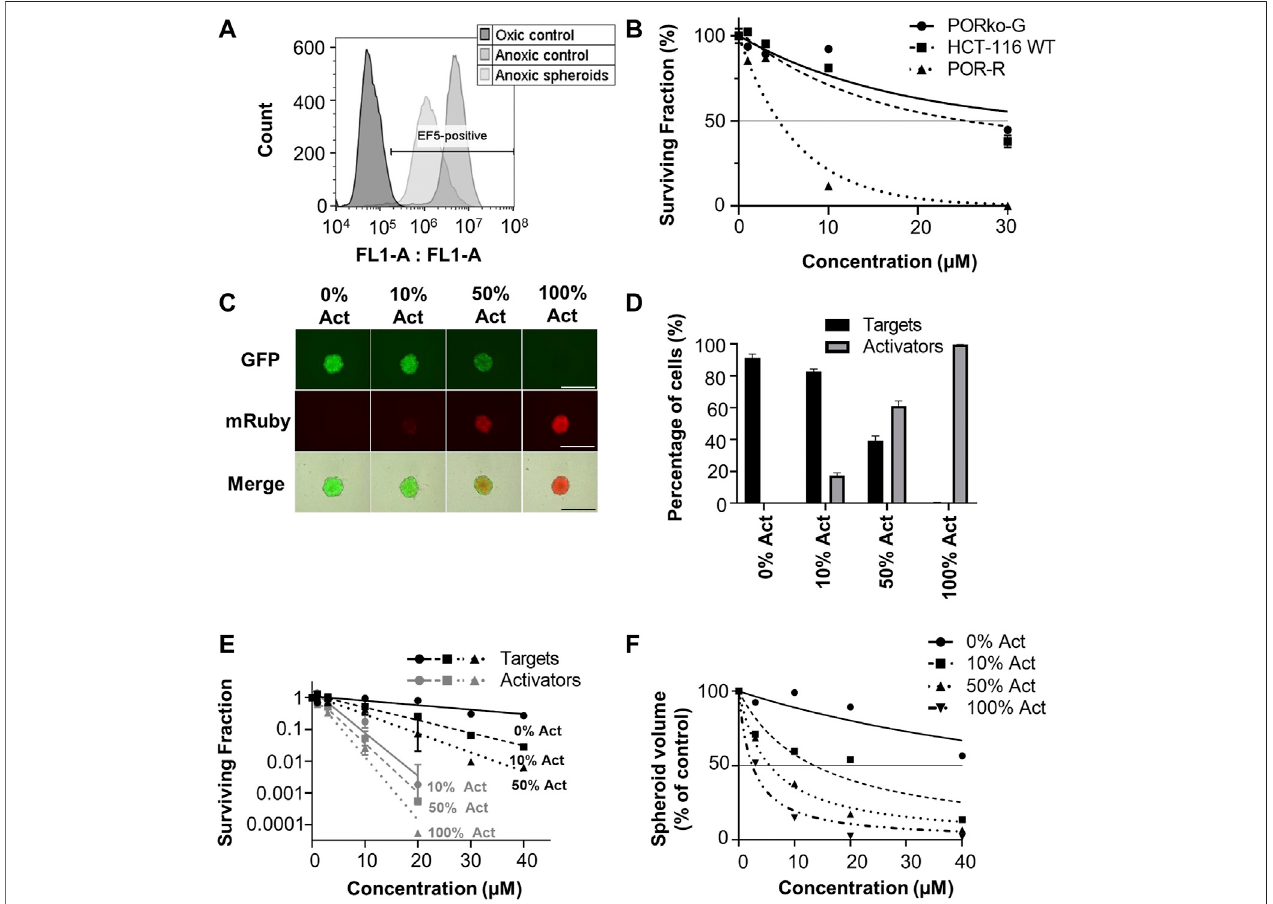
FIGURE 6 | Bystander ef fi ciency of CP-506 in spheroid co-cultures. Multicellular spheroids were established by seeding differing proportions of target (PORko-G) andactivatorcells(POR-R)andgrowingfor4 daysinultra-lowattachment,roundbottom96-wellplates. (A) FlowcytometricanalysisofEF5bindingupontheenzymatic dissociation of anoxia pre-equilibrated POR-R spheroids. The hypoxic population was de fi ned by the hypoxia-selective metabolism and binding of EF5 in monolayer controls. (B) ClonogenicsurvivalafterexposureofspheroidculturestoCP-506for4 hunderanoxicconditions( < 1 ppmO 2 ).IC 50 valueswereinterpolatedfromthe fi tted dose response curve as the concentration required to reduce the plating ef fi ciency to 50% of the untreated controls (shown by the reference line). Values are the mean ± SEM for three independent experiments. (C) Fluorescent microscope images of representative spheroids showing target (GFP-positive) and activator cells (mRuby-positive) at the anticipated proportions based on their initial seeding densities. Images were acquired at 4 X objective using a JuliStage Real-Time Cell History Recorder (NanoEnTek, Seoul, Korea). Scale bar indicates 1 mm. (D) Flow cytometric detection of target and activator cells in spheroid co-cultures based on GFP expression. The parental cell line(HCT-116 WT)wasused as anegativecontrol. Values are the mean ± SEM for three independent experiments. (E) Clonogenic survival of target and activator cells (Act) in spheroid co-cultures treated with CP-506 for 4 h under anoxic conditions ( < 1 ppm O 2 ). Spheroids were then enzymatically dissociated and plated in parallel in media supplemented with 2 µM puromycin or 1 mg/ml geneticin to select for activator and target cells respectively. Values are the mean ± SEM for three independent experiments. (F) Growth delay after exposure of spheroid co-cultures to CP-506 for 4 h under anoxic conditions ( < 1 ppm O 2 ). Spheroid volumes were quanti fi ed at endpoint (day 14 post-treatment) using a previously described method of image analysis (Mao et al., 2018). Values are the mean ± SEM for three independent experiments.